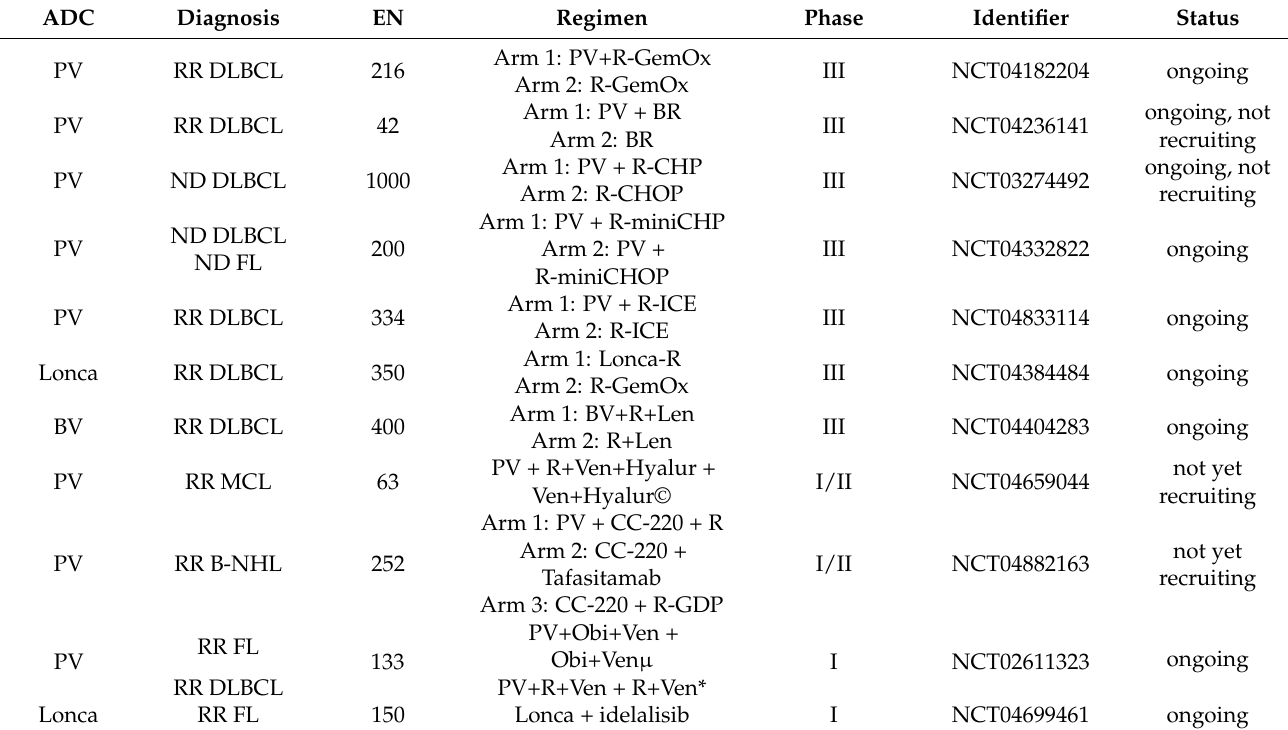
Table 3. Antibody-drug conjugates-phase III ongoing clinical trials and phase I-II ongoing chemotherapy free clinical trials with no available results (NCT03677154, NCT03533283, NCT03671018 are included in Table 4; EN, estimated enrollment; RR, relapse and/or refractory; ND, newly diagnosed; B-NHL, B-cell non-Hodgkin lymphoma; DLBCL, Diffuse large B-cell lymphoma; FL, follicular lymphoma; PV, polatuzumab vedotin; CHOP, cyclophosphamide, doxorubicin, vincristine, prednisone; miniCHOP, dose modified CHOP, CHP, cyclophosphamide, doxorubicin, prednisone; miniCHP, dose